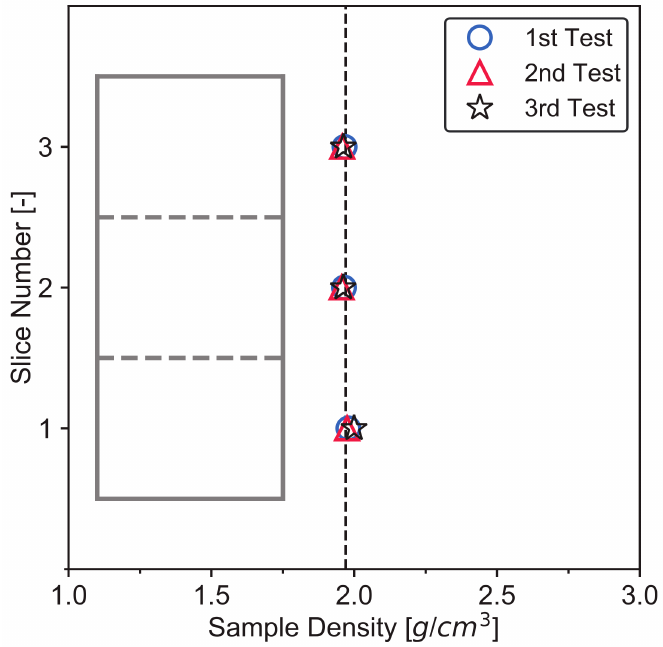
Figure 7. Sample density at different layers of the sand–clay mixture sample (75% K clay content) after S1